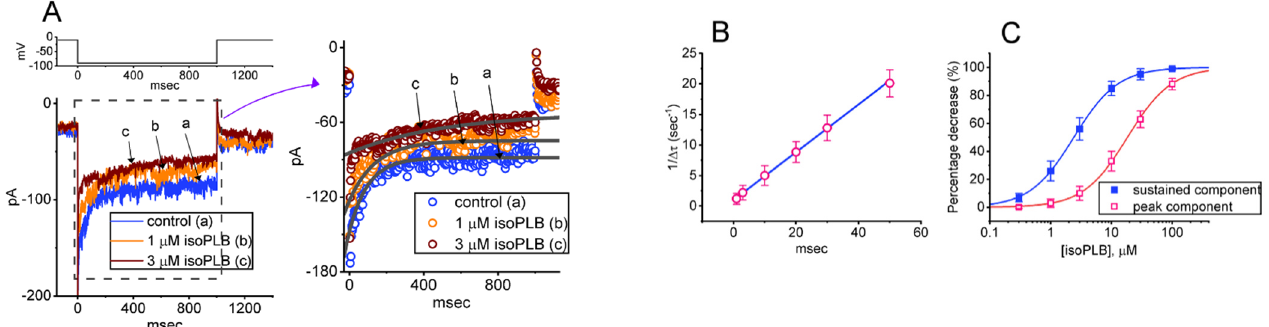
Figure 1. Effect of isoPLB on I K(erg) identified from pituitary GH 3 cells. These recordings were undertaken in cells immersed in a high-K + , Ca 2+ -free solution containing 1 µ M tetrodotoxin (TTX) and 0.5 mM CdCl 2 , refilling the pipette that was used with K + -enriched internal solution. ( A ) Representative current traces evoked by 1-sec step hyperpolarization (indicated in the upper part). a: control (i.e., absence of isoPLB), b: 1 µ M isoPLB; c: 3 µ M isoPLB. The right side of ( A ) indicates an expanded record shown in dashed box (left side). Current trajectory, the data points of which are indicated in open circles, was satisfactorily fitted with single exponential (in smooth gray line). In ( B ), a linear relationship of the resulting 1/ ∆ τ value versus the isoPLB concentration was constructed and then plotted (mean ± SEM; n = 8 for each point). From the minimal reaction scheme (as elaborated under Materials and Methods), the forward ( k +1* ) and backward ( k − 1 ) rate constants for the isoPLB-mediated block of I K(erg) in GH 3 cells were computed as 0.39 sec − 1 μ M − 1 and 1.01 sec − 1 , respectively. ( C ) Concentration-dependent relationship of isoPLB on the peak (red open squares) or sustained (blue solid squares) components of I K(erg) evoked by 1-sec membrane hyperpolarization from − 10 to − 90 mV (mean ± SEM; n = 8 for each point). The smooth line indicates the goodness-of-fit to the Hill equation as described under Materials and Methods.